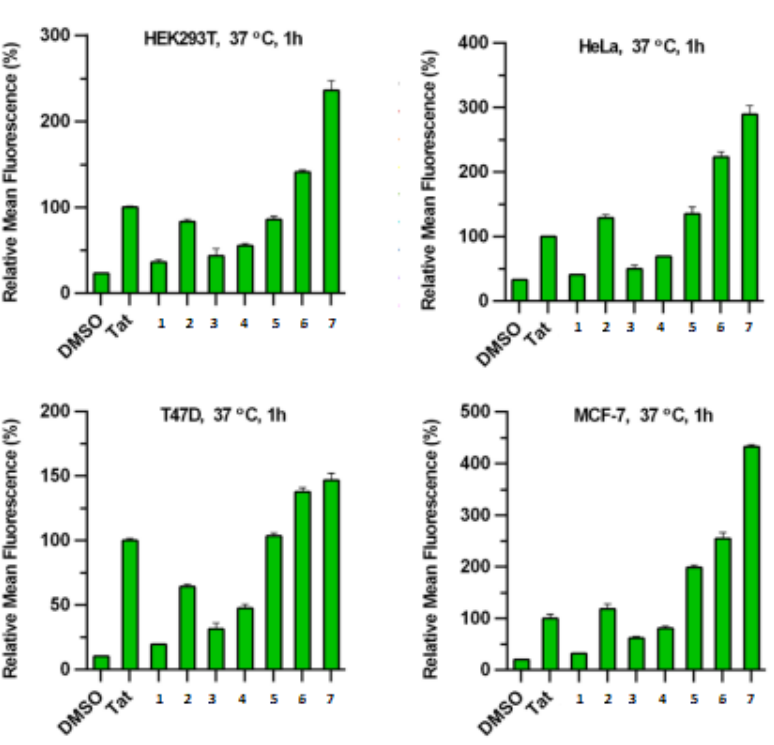
Figure 9. Flow cytometry analysis of stapled α -helical peptides with different cross-links in different cell-lines. Values are normalized with respect to Tat peptide ( 1 = unstapled; 2 = all-hydrocarbon-; 3 = lactam-; 4 = triazole-; 5 = vinyl sulfide-; 6 = xylene-; 7 = perfluoroaryl-)